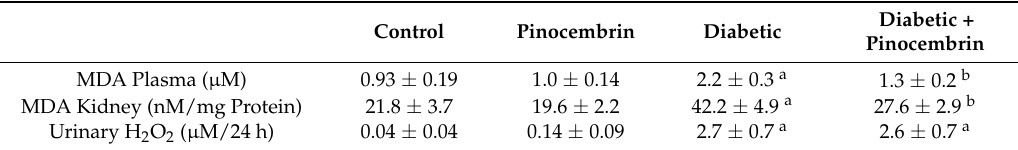
Figure 7. Biomarkers of renal damage in the schemes of treatment with pinocembrin, 40th day in the preventive scheme and 60th day in the corrective scheme. ( A ) Kidney injury molecule-1 (Kim-1) levels in the preventive and the corrective schemes; ( B ) N -acetyl- β -glucosaminidase (NAG) levels in the preventive and the corrective schemes; ( C ) Neutrophil gelatinase-associated lipocalin (NGAL) levels in the preventive and the corrective schemes. a p < 0.02 vs. Control, b p < 0.005 vs. Diabetic, n = 5. Table 2. Oxidative Stress Parameters in Preventive Model.